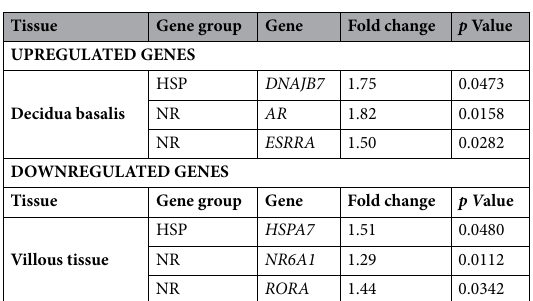
Table 4. Differentially regulated SPTB vs. ETB transcripts in the discovery